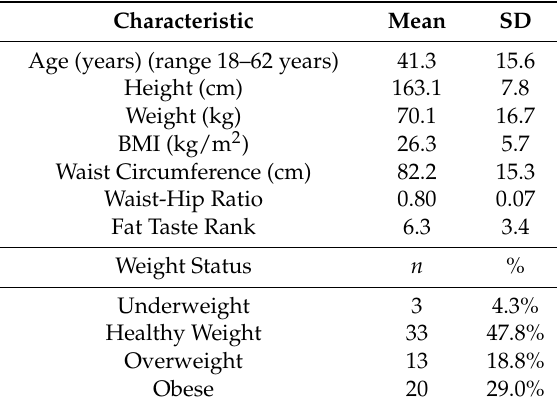
Table 2. Characteristics of study participants.